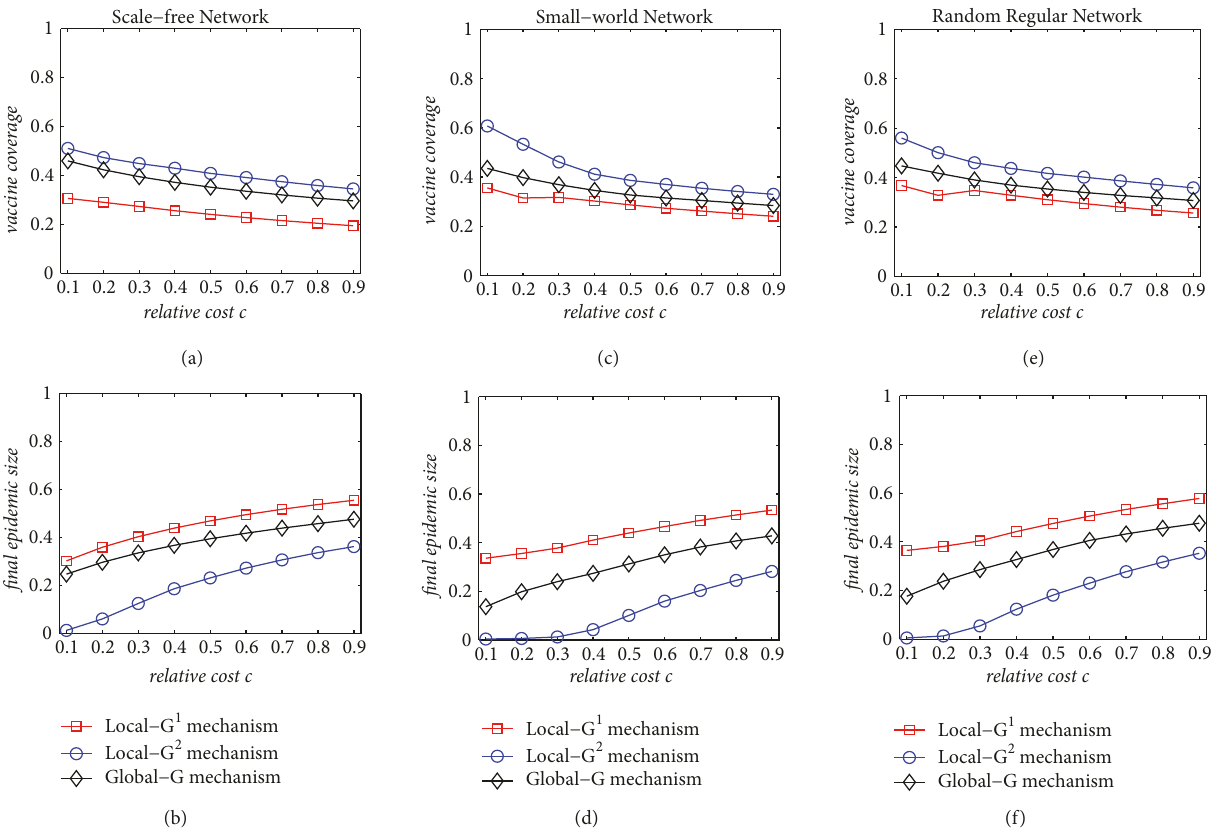
Figure 1: The final vaccine coverage and epidemic size as the relative cost increases under different decision-making mechanisms in three types of social networks. Simulations are carried out on scale-free networks ((a) and (b)), small-world networks ((c) and (d)), and random regular networks ((e) and (f)). The results are averaged over 100 independent network simulations with network size 𝑁 = 10,000 and average degree ⟨𝑘⟩ = 4